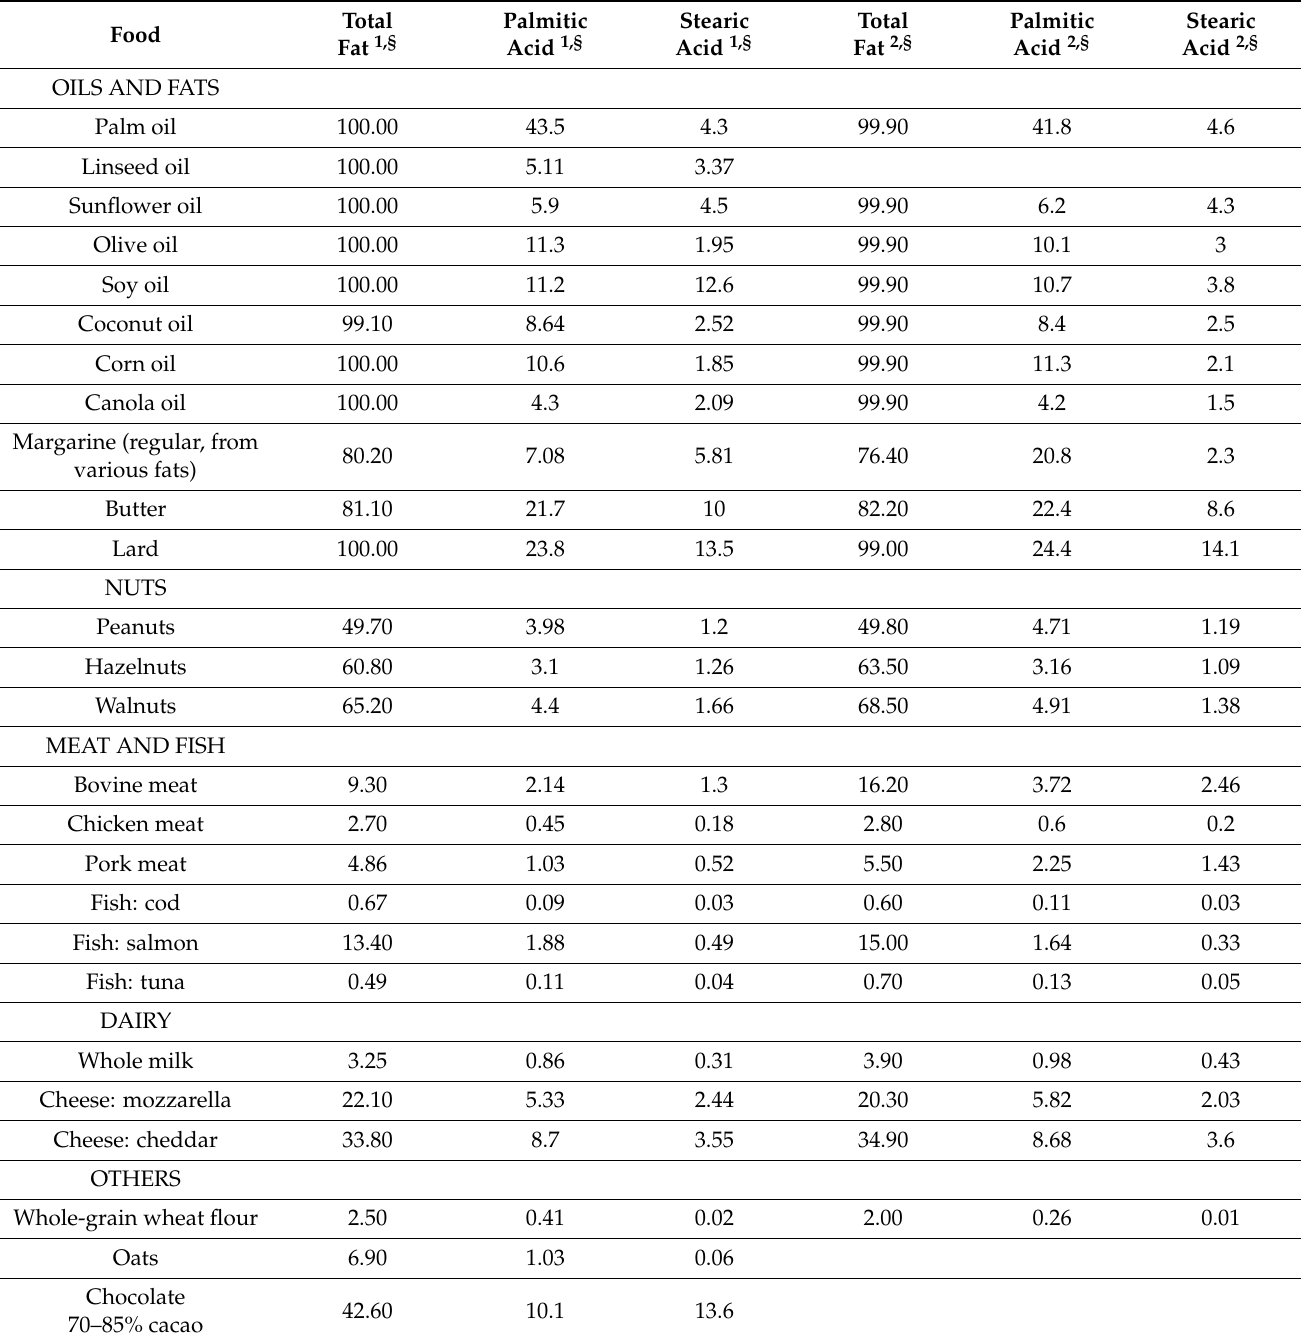
Table 2. Content of total fats, palmitic acid and stearic acid in foods expressed as g/100 g of food (edible portion). Source of data: 1 U.S. Department of Agriculture. Food Data Central Data obtained from The National Nutrient Database for Standard Reference Legacy Release, and 2 UK—McCance Widdowson’s Composition of Foods